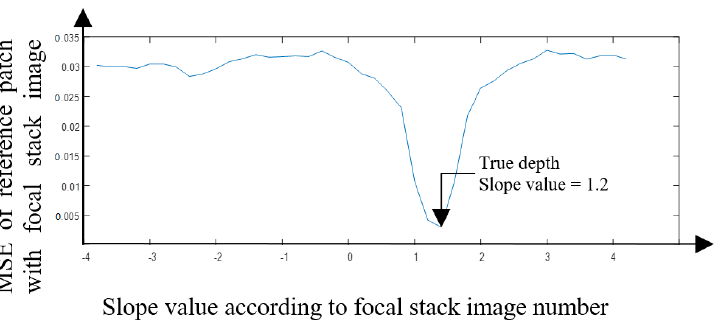
Figure 17. MSE for the central image patch and the patch at different focal lengths when the depth is estimated correctly.